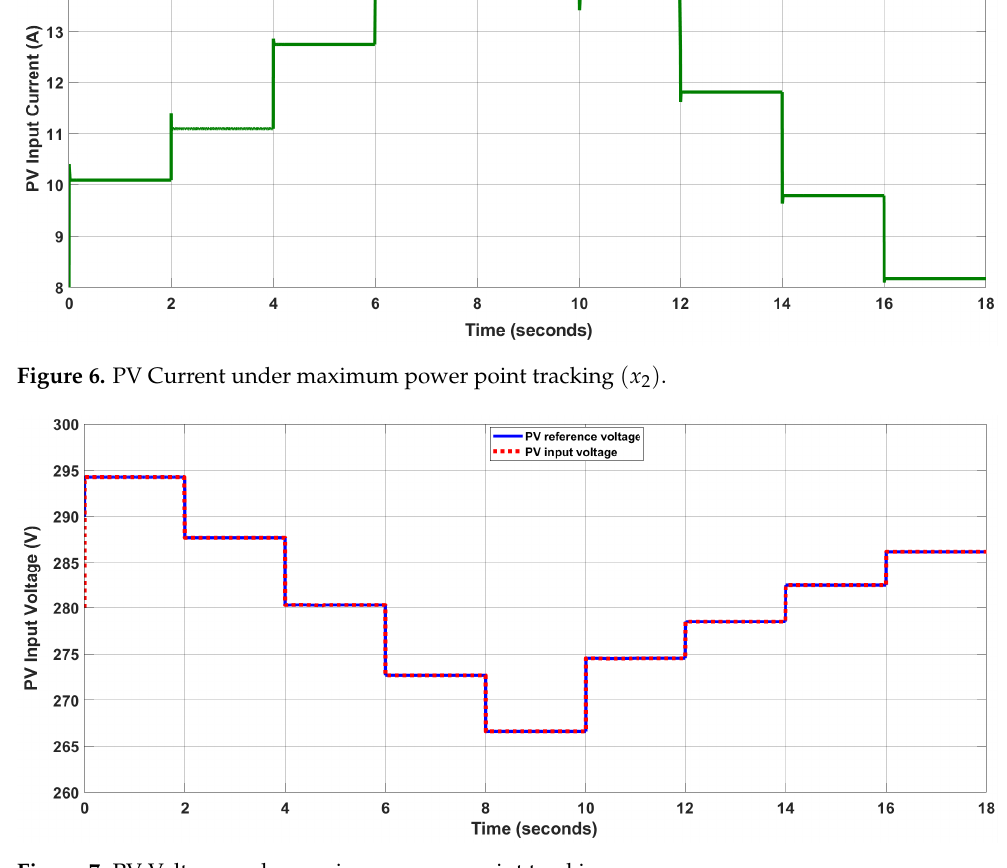
Figure 7. PV Voltage under maximum power point tracking.